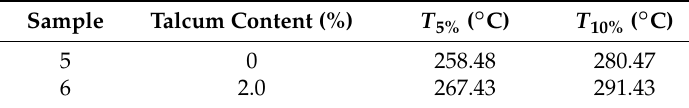
Figure 2. Thermogravimetric curves of WUVCW with 0 ( A , sample 5) and 2.0% ( B , sample 6) talcum content. Table 6. Thermal properties of WUVCW with 0 and 2.0% talcum content.